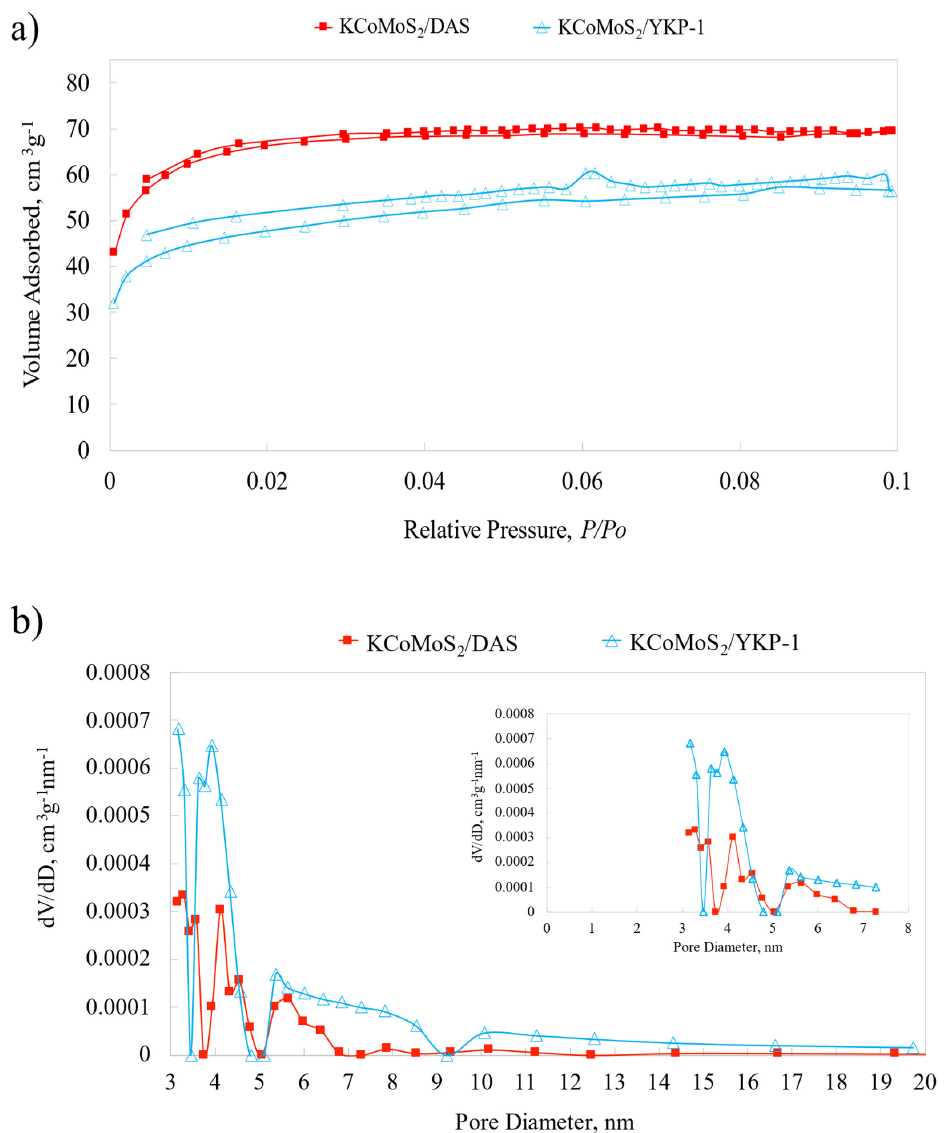
Figure 1. Characterization of the powder-activated carbons: ( a ) N 2 (77K) adsorption–desorption isotherms and ( b ) pore size distribution.